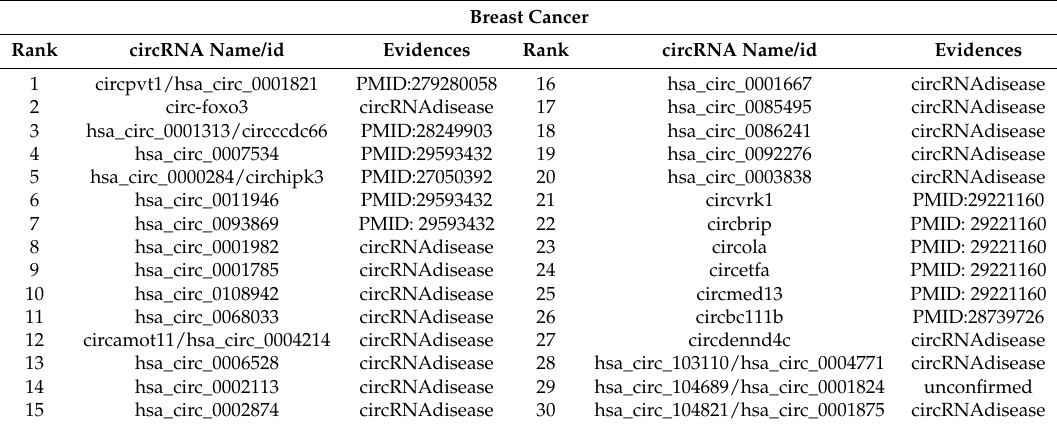
Table 3. The top 30 breast cancer related candidates